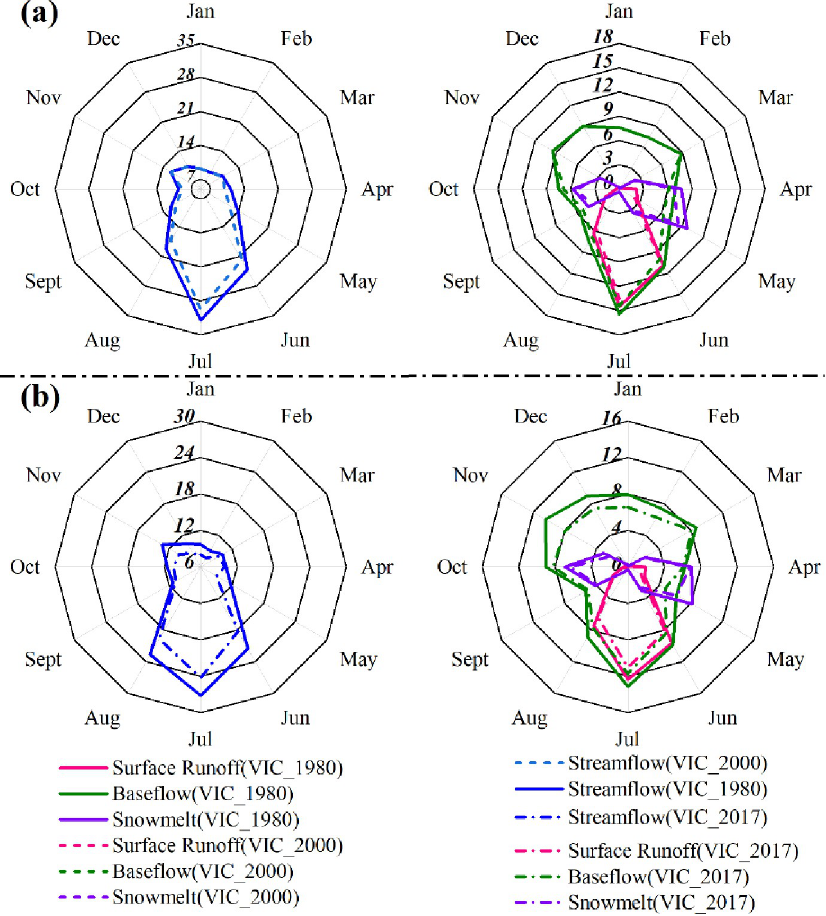
Fig 11. Monthly average changes in streamflow, surface runoff, baseflow, and snowmelt are driven by the VIC_1980, VIC_2000, and VIC_2017 scenarios for the entire ELB during impact phase I (a) and impact phase II (b).